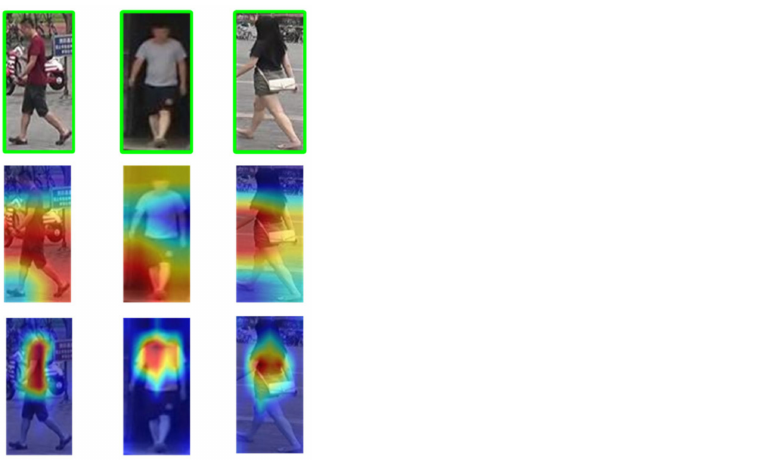
Figure 7. Visualization of feature maps based on different Re-ID models. (i.e., ResNet-50 and TL-TransNet). Table 5. The effectiveness of parameter λ on TL-TransNet.